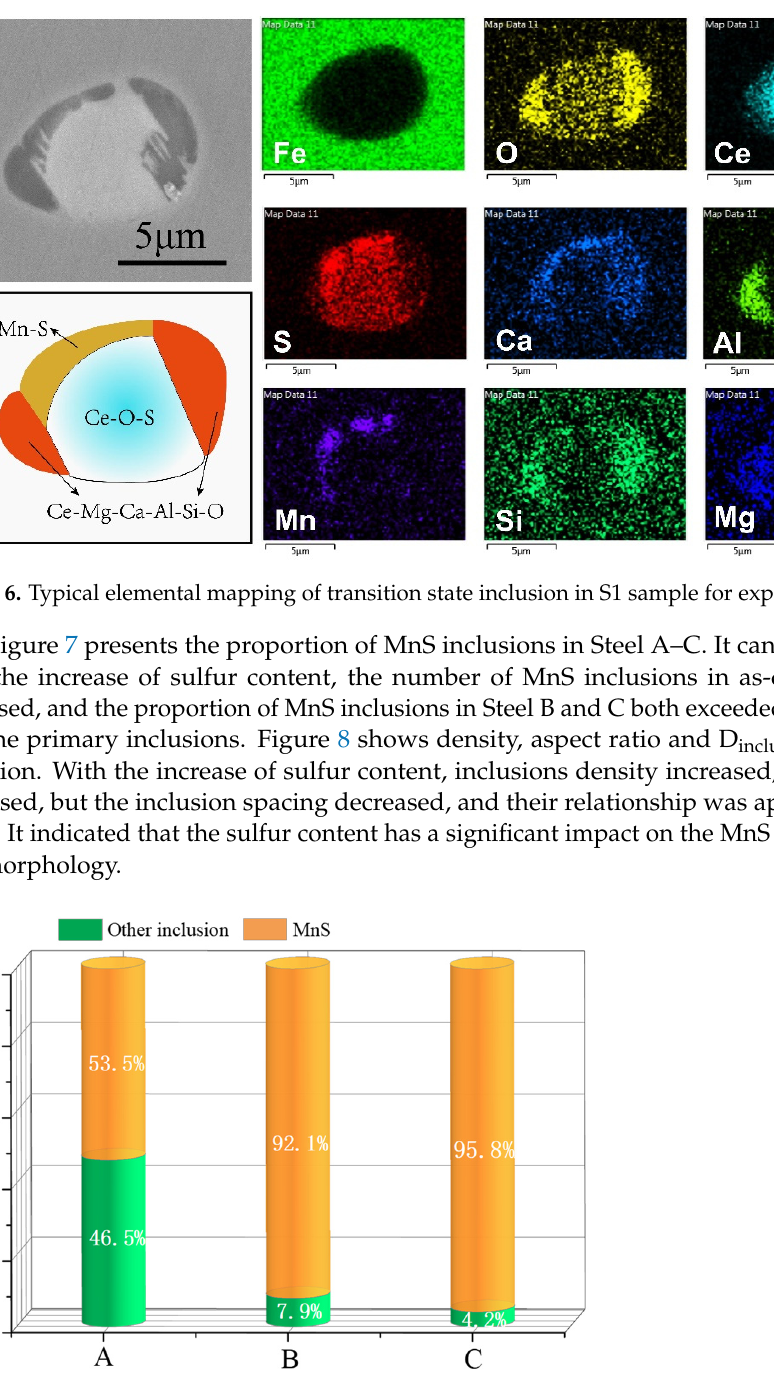
Figure 8. Inclusion density, aspect ratio and D inclusion spacing in Sample S2 of Steel A–C. ( a ) Inclusion density. ( b ) Aspect ratio. ( c ) D inclusion spacing . A summary of the phenomenon that the sulfur content has an impact on inclusion evolution in liquid steel at 1873K and MnS inclusion precipitation during solidification can be obtained as follows, a type of double structure inclusion that Ce-O-S inclusion serv- ing as a core wrapped by Ce-Ca-Mg-Al-Si-O inclusions can form in liquid steel after Ce- Mg lump addition and disappeared with experiment time prolonging. In Sample S2, Ce- O-S inclusion can not be detected in Steel A but can be found in Steel B and Steel C. The